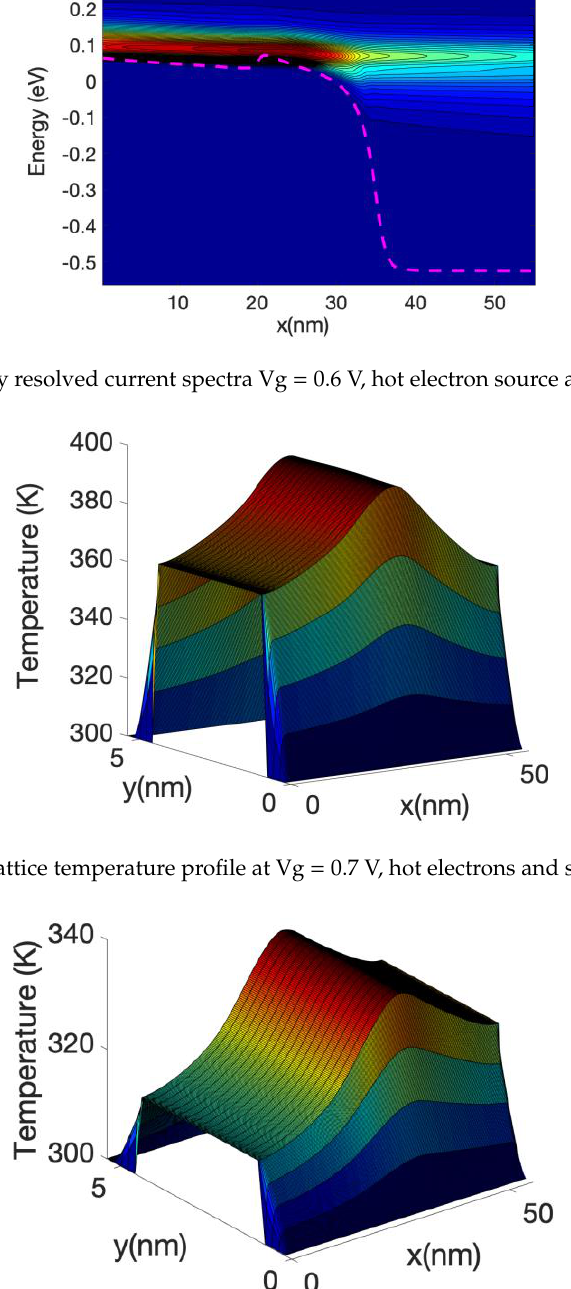
Figure 17. Lattice temperature profile at Vg = 0.6 V, hot electron source and self-heating.